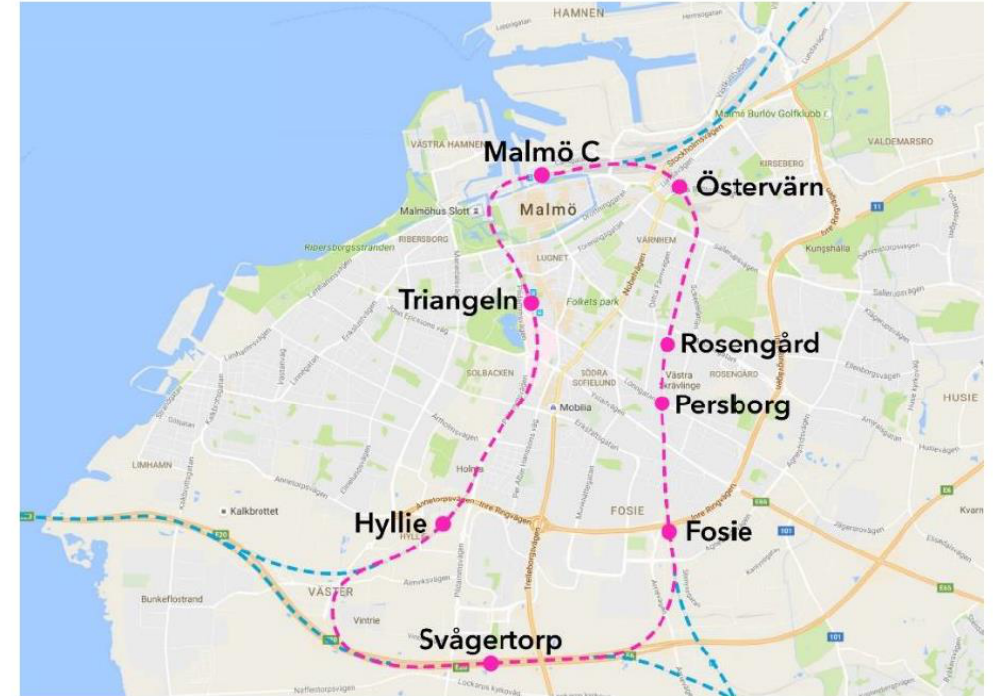
Figure 1. The continental of Malmö. Figure shows that Rosengård station is the new station, and by establishing this new station, the whole continental line of the city has been activated. The Swedish Transport Administration wants to make it easier to travel between the eastern and western districts by opening up to passenger traffic on the Continental Line as well as facilitating the connection between districts in Malmö with the other parts of Öresund region. Source: [40].